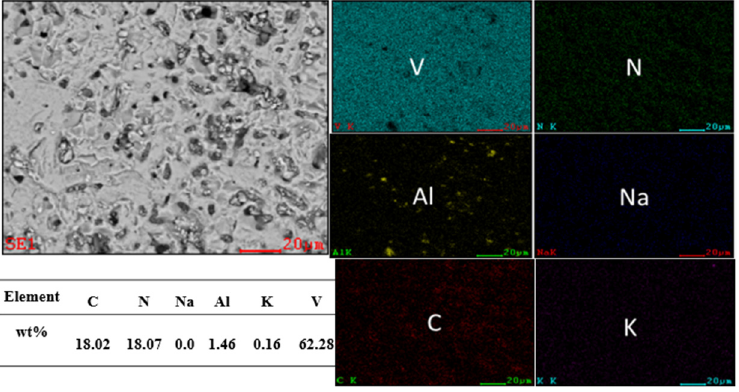
Figure 8. Analysis of edge position morphology and interface element content of vanadium nitride products.